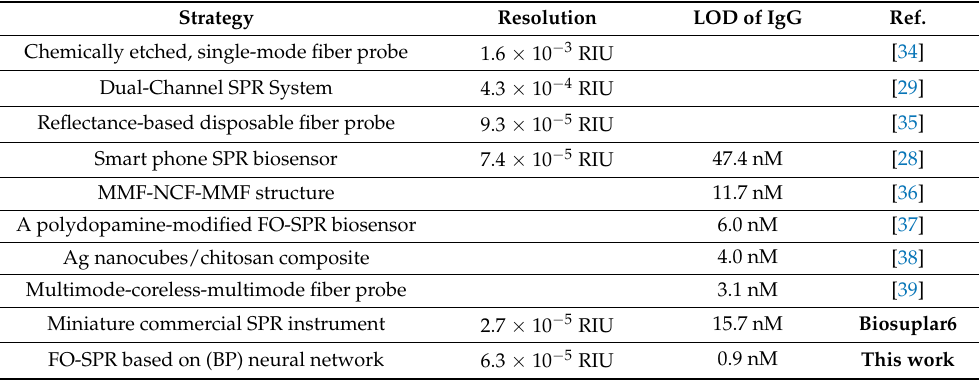
Table 1. Comparison of the sensing performance for a small-sized SPR sensor.